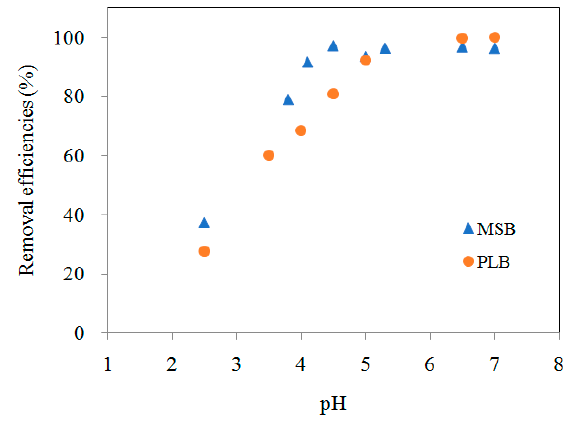
Figure 8. Effect of pH on the adsorption of Cd (25 mg/L).